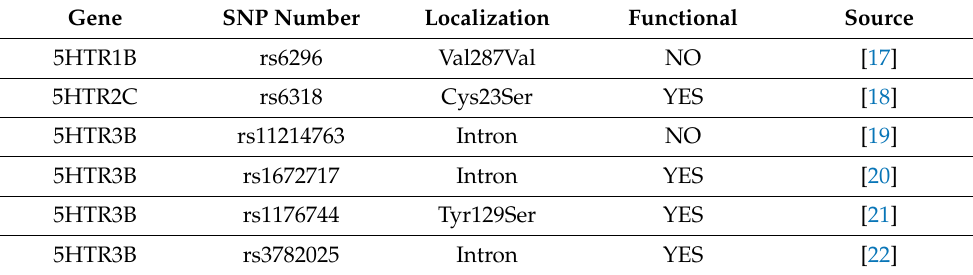
Table 1. Characteristics of the investigated